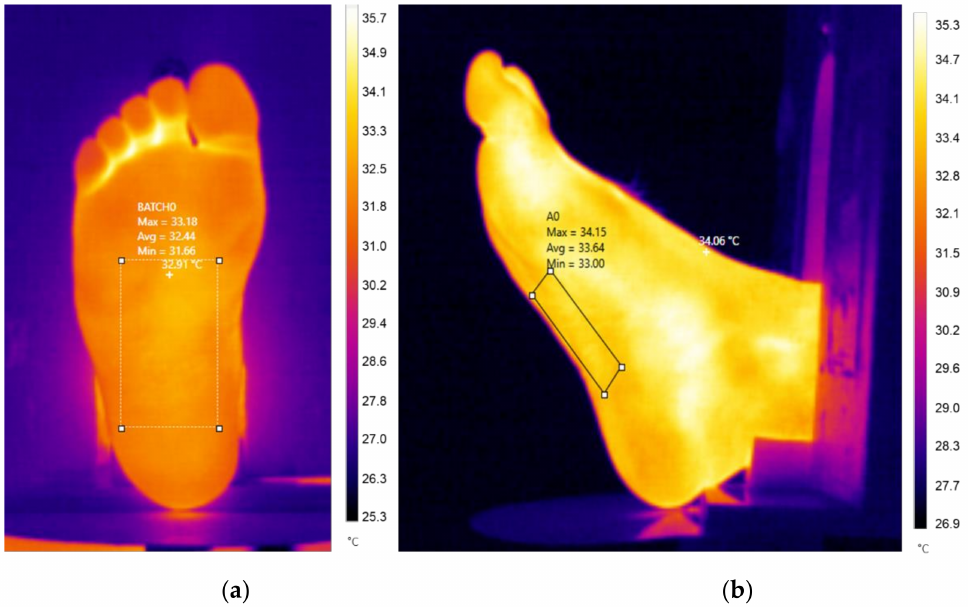
Figure 5. Thermal images taken from different viewpoints. ( a ) Reference sample at a normal angle. ( b ) The last sample at a 90 ◦ angle change position. For each sample, the average temperature was retrieved within a marker